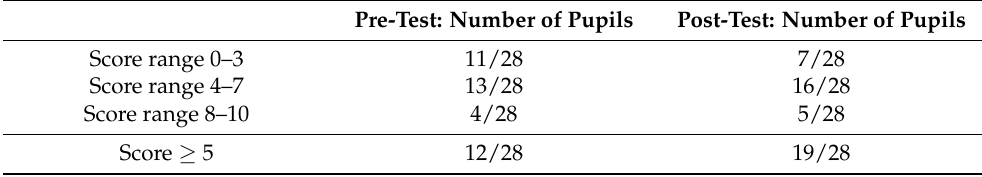
Table 7. Descriptive analysis for the pantomime